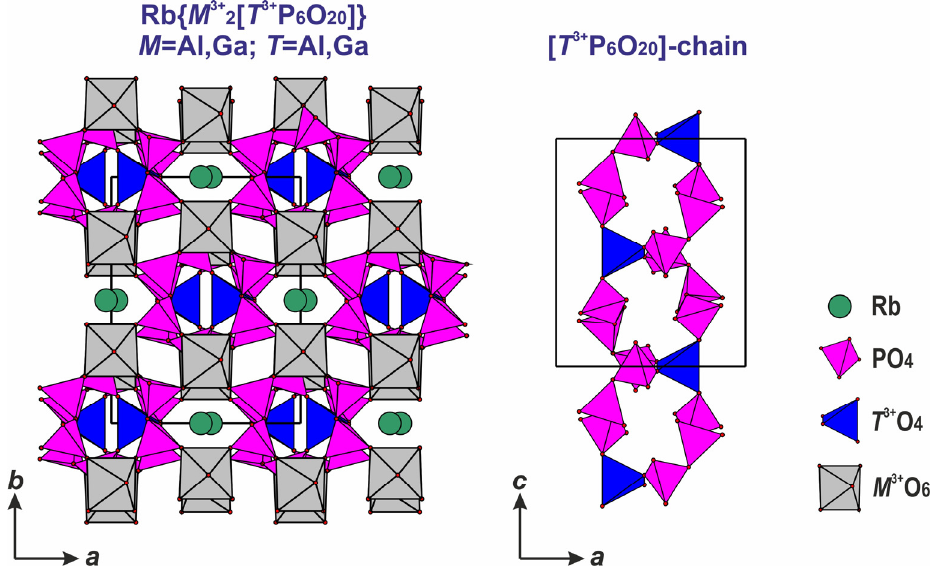
Figure 7. The general view of the crystal structure of compounds with the general formula Rb{ [6] M 3+2 [ [4] T 3+ P 6 O 20 ]} (where M = Al, Ga; T = Al, Ga [26,51]) and a tetrahedral chain going along [001].